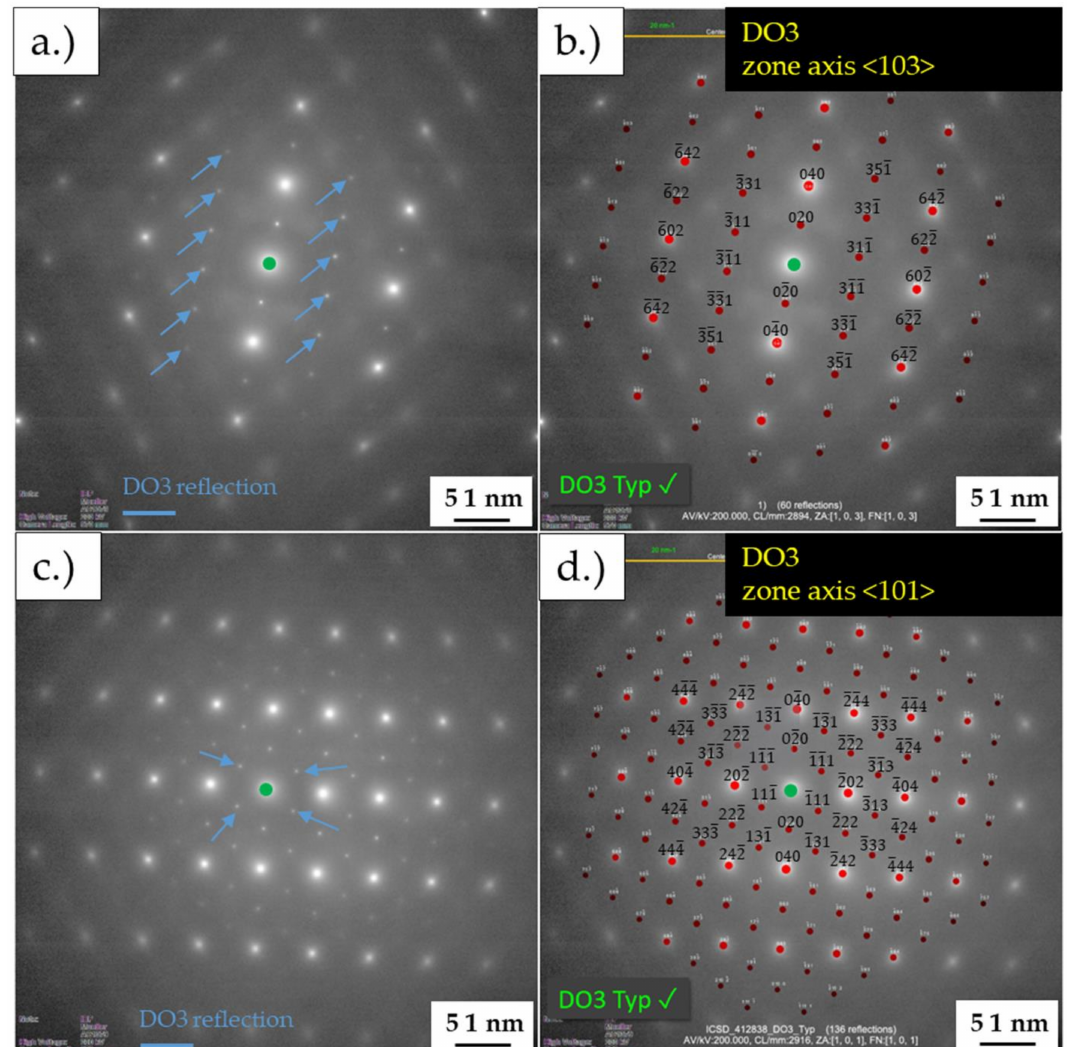
Figure 4. Diffraction patterns from TEM investigation of cast samples. Blue arrows indicate the DO3 reflections: ( a ) AC1378 with DO3 superlattice reflections in <103> zone axis; ( b ) corresponding simulated DO3 pattern; ( c ) AC1379 diffraction pattern in <101> zone axis in accordance with ( d ) simulated DO3 diffraction. (Courtesy of Thomas E. Weirich, GfE RWTH